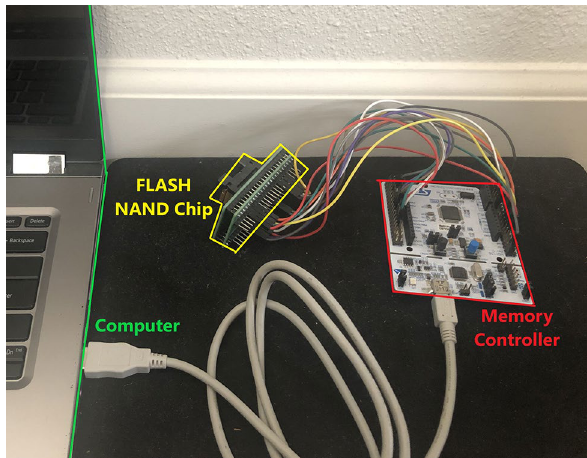
Fig. 2 Experimental setup